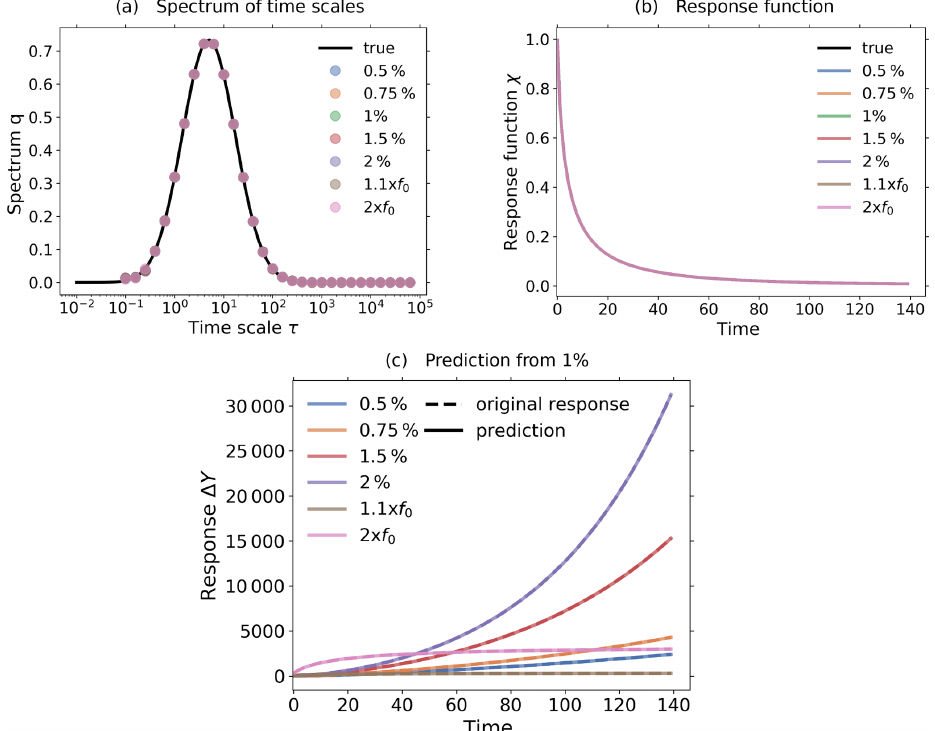
Figure 3. Demonstration of robust recovery for noise-free data from the toy model: (a) recovered q λ ; (b) recovered χ(t) ; and (c) original responses and predictions using χ(t) derived from the 1% experiment. Reconstructed values are almost indistinguishable from original data. To plot the “true” spectrum of the toy model in subfigure (a) , we used the relation q ∗ = a /(cid:49) log 10 τ , which can be obtained by comparing Eq. (33) with Eq. (12). Since from the discrete spectrum the response function and the response may be obtained for any time t , the spectrum is plotted as dots, while the response function and response are plotted as continuous lines. The regularization parameter is chosen as λ = 10 − 8 .